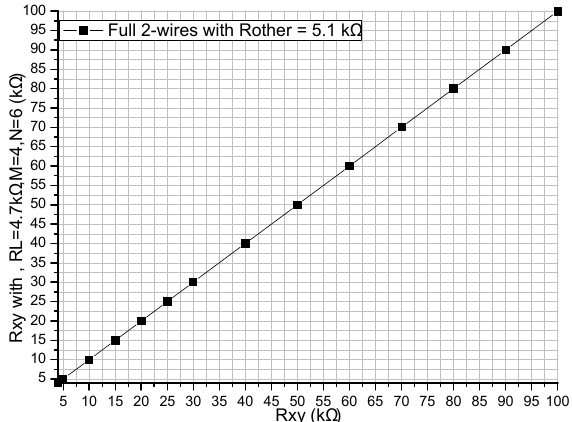
Figure 7. Measurement result of the EBT’s resistance in the full two ‐ wire prototype circuit.